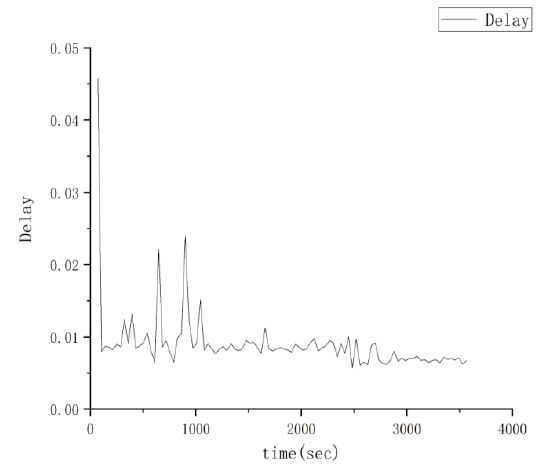
Figure 6. Time delay data of the vehicular network.